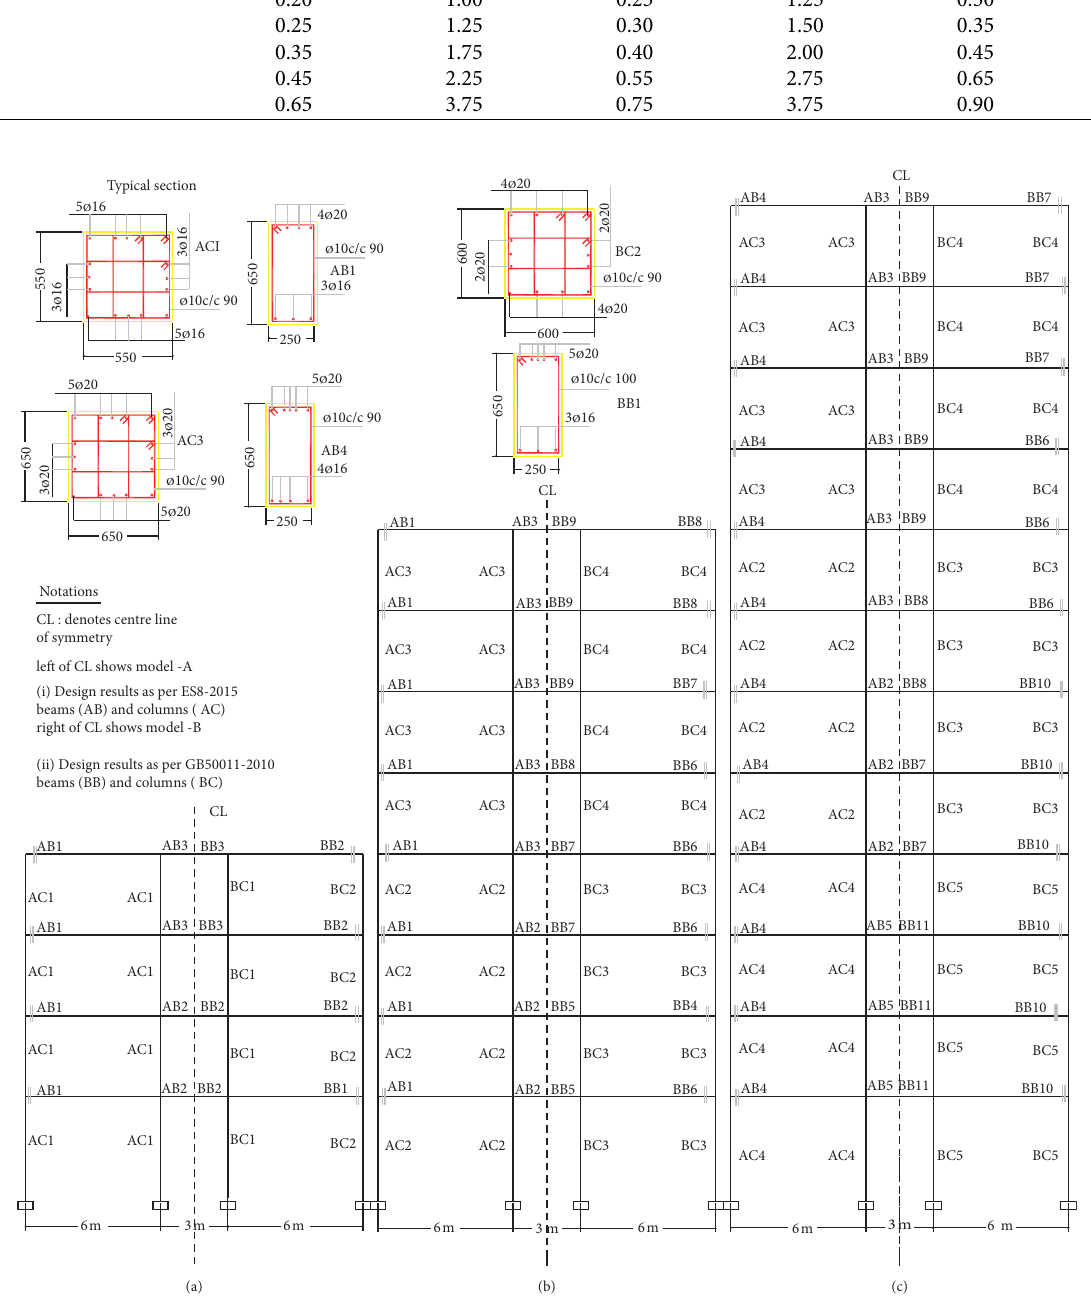
Figure 17: Reinforcement design diagram for (a) 4-, (b) 8-, and (c) 12-story RC frame designed as per ES8-15 and